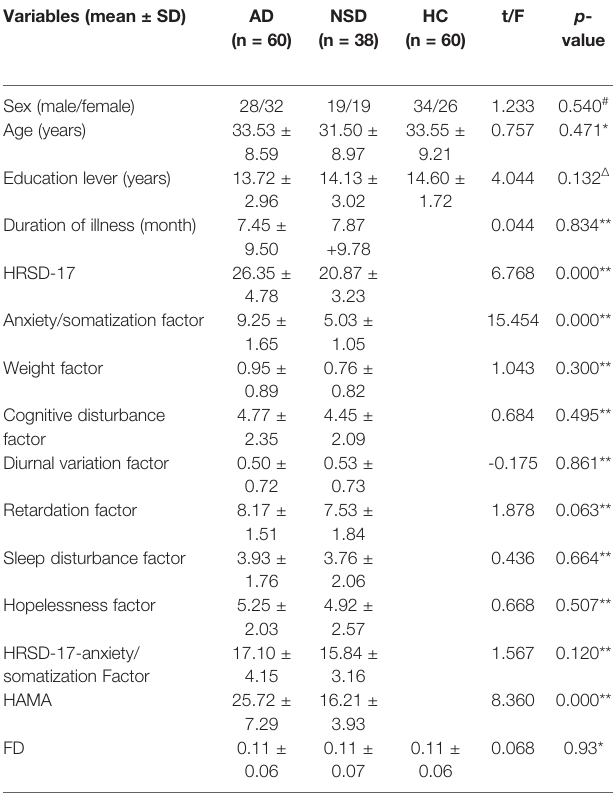
TABLE 1 | Demographic, clinical characteristics and frame-wise displacement of all